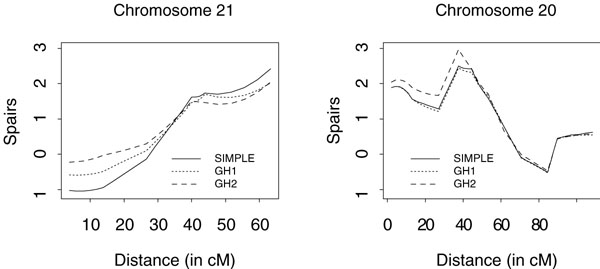
Spairs scores using GENEHUNTER (GH) and SIMPLE for chromosome 21 and chromosome 20 GH1: GH scores with skipped pedigrees; GH2: GH scores without skipped pedigrees.